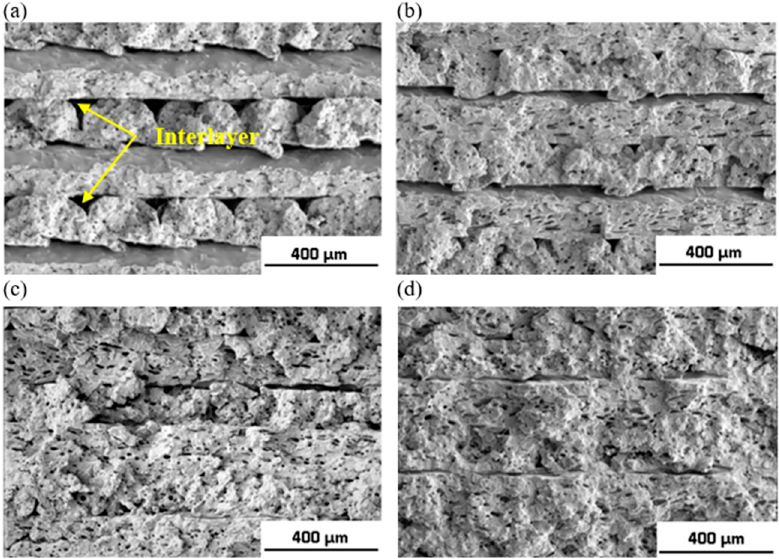
Figure 5. Mesostructure of CF-ABS composites printed at ( a ) 230 °C, ( b ) 250 °C, ( c ) 270 °C, ( d ) 290 °C [100×] . [100 ×